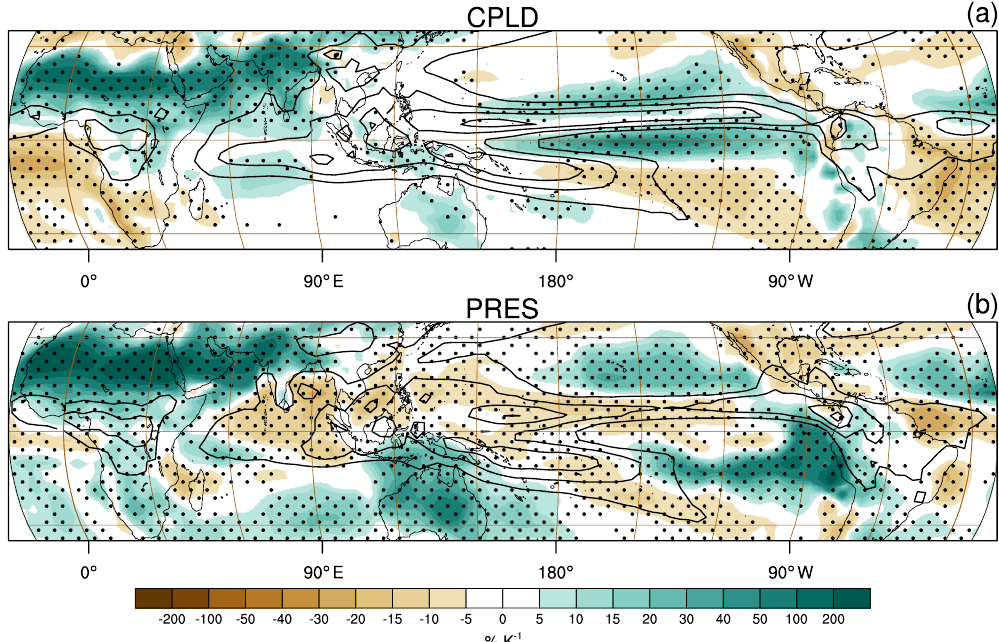
Figure 2. As Fig. 1, except showing the precipitation response as a percentage of the preindustrial control climatology (shading). The precipitation rate from the preindustrial control climatology is shown by thick black contours, interval 2mmd − 1 and starting at 4mmd − 1 . Stippling indicates regions where at least all but one of the models in the model group agree on the sign of the